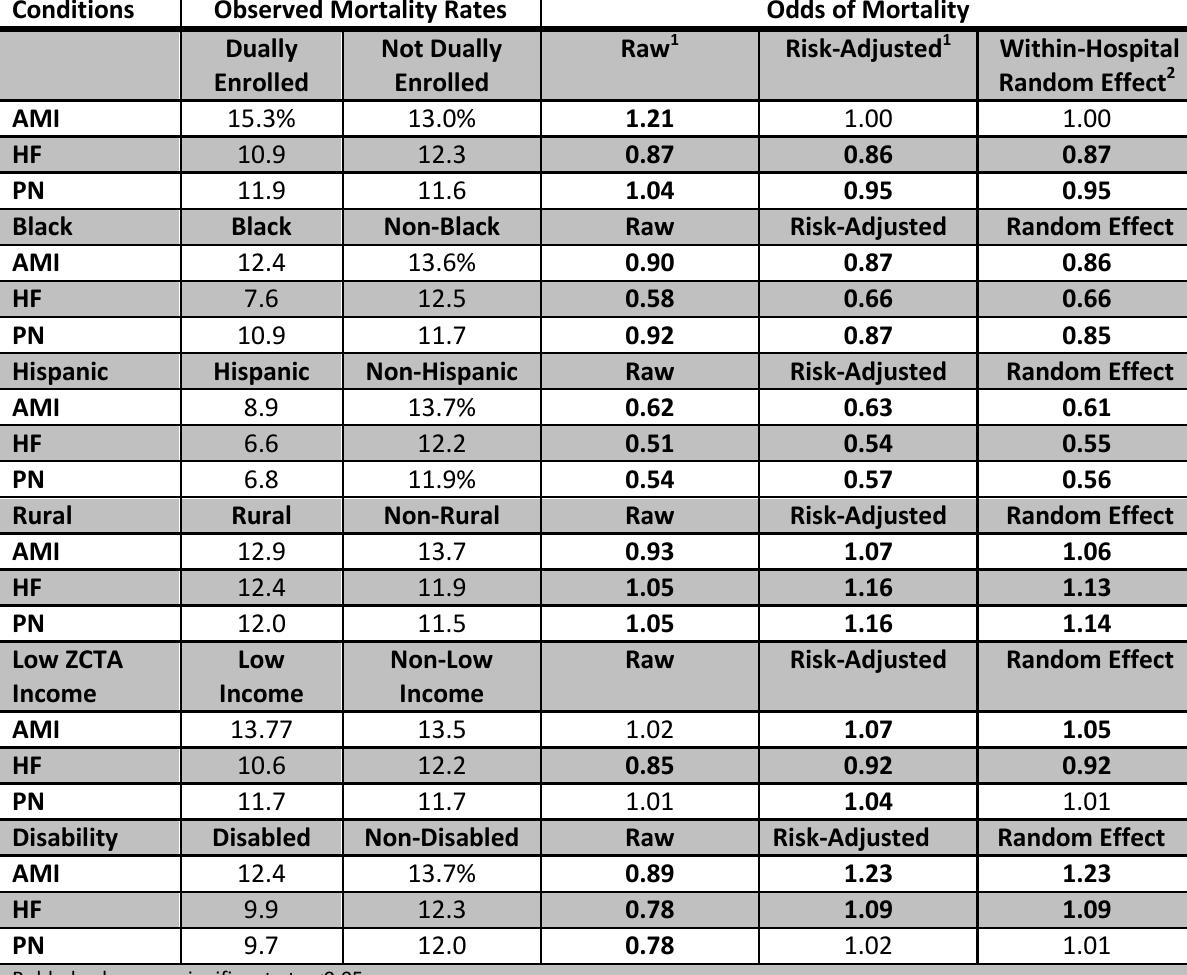
Table 7.6. Beneficiary Social Risk and Condition-Specific Mortality Rates (AMI, HF,